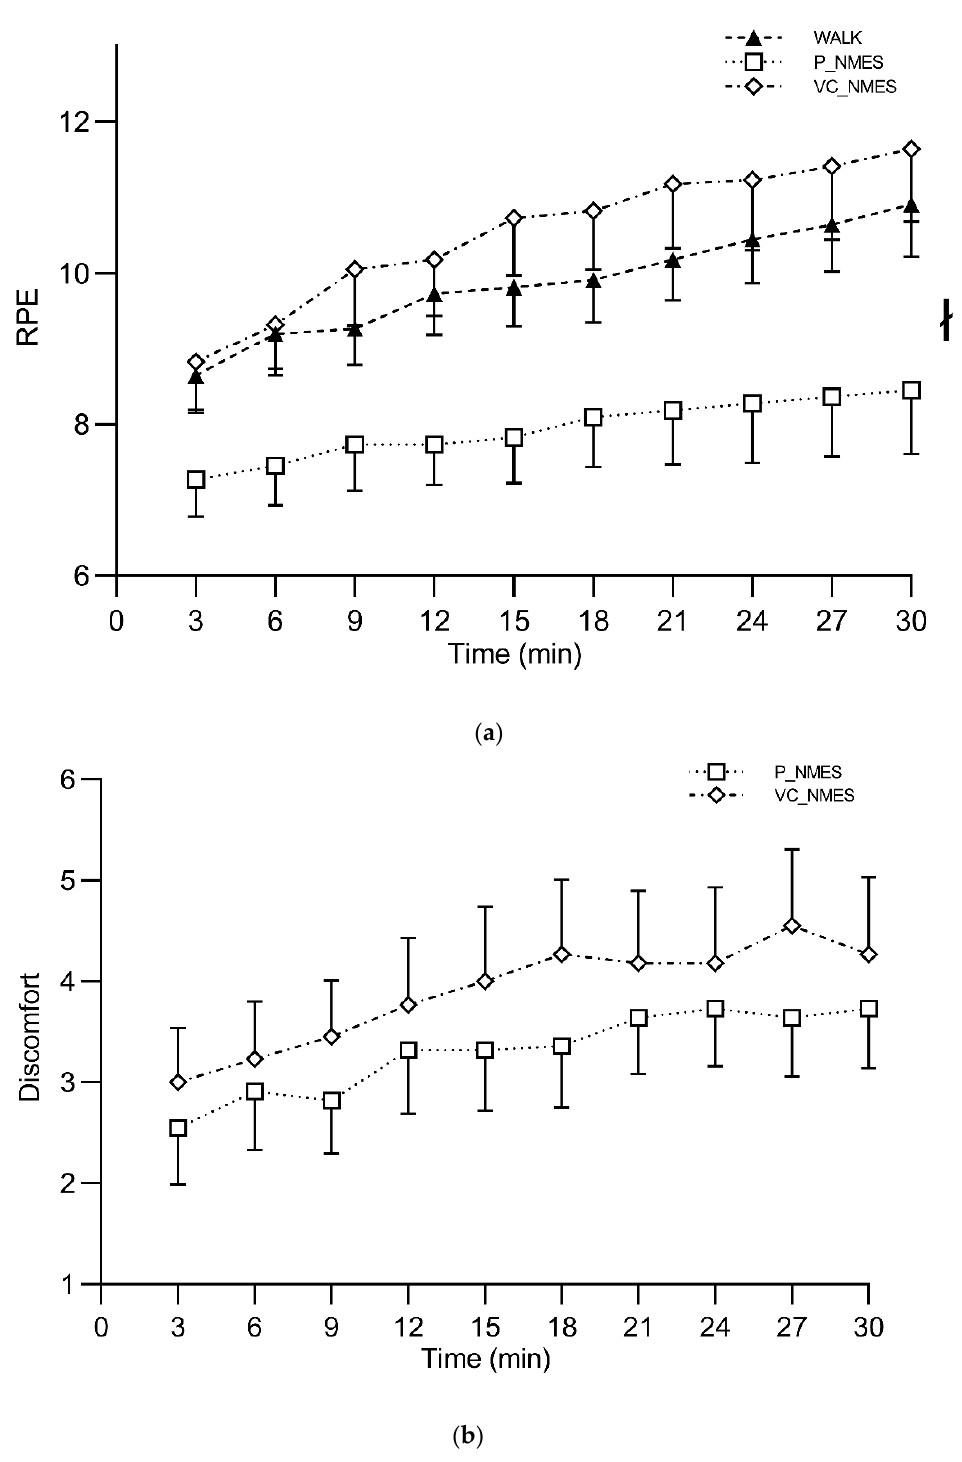
Figure 5. Rate of perceived exertion (6–20 RPE) ( a ) and visual analog scale (VAS) for discomfort ( b ) during exercise, for Study 2. Symbols: ł , the main effect of conditions ( p < 0.05). Values are reported as mean (± SEM).